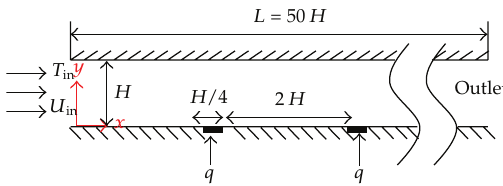
Figure 1: Parallel plates channel with discrete heat